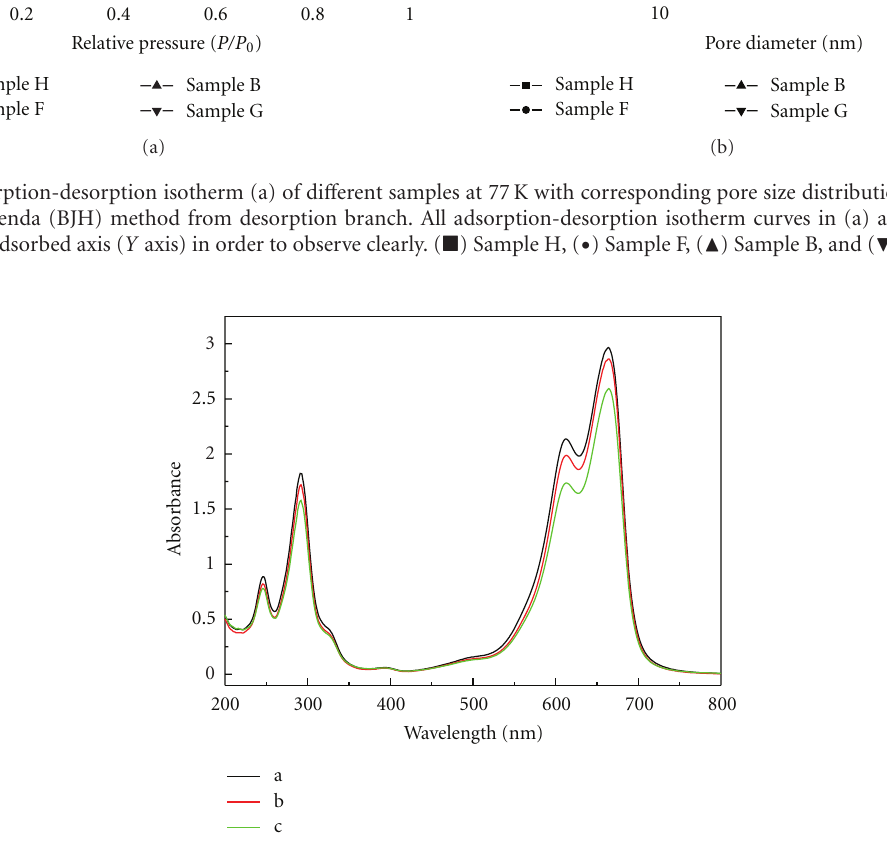
Figure 7: The UV-Vis of MB solution after suspending catalysts in dark for 30min, a: no catalyst; b: commercial TiO 2 and c: Sample